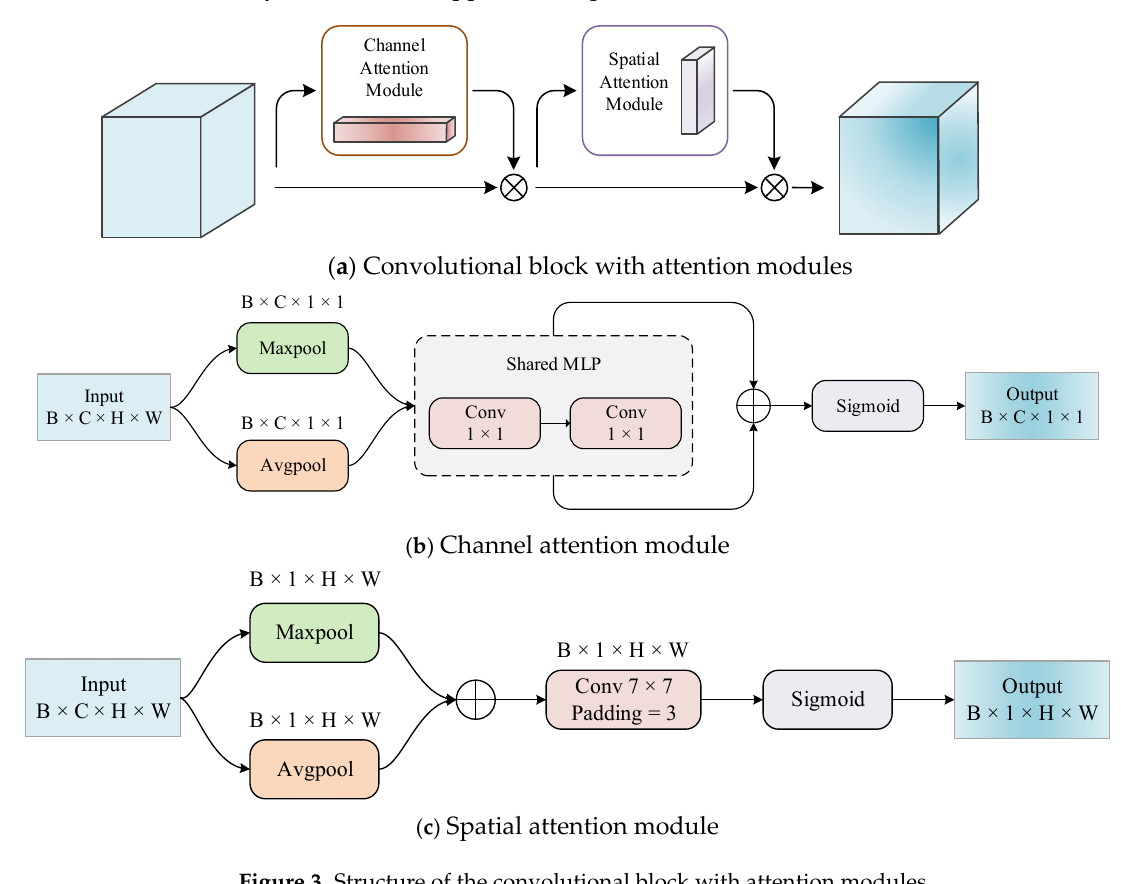
Figure 3. Structure of the convolutional block with attention modules.